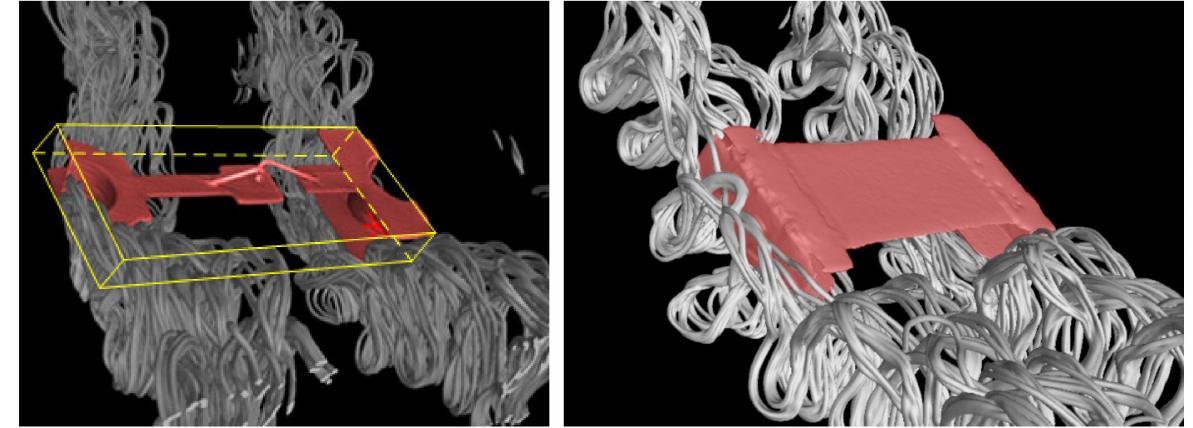
Figure 3. Examples of SMD chip components connected by an NCA onto a conductive ribbon.